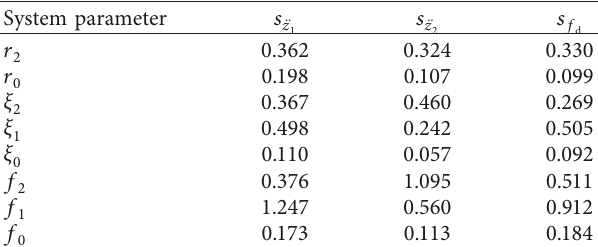
Figure 11: Influences of f on € z , € z , and f : (a) the amplitude frequency characteristics J 0 1 2 d frequency characteristics J at different values of f ; (c) the amplitude frequency characteristics J 2 0 , and σ versus f . σ 2 3 0 Table 3: The sensitivity values of each